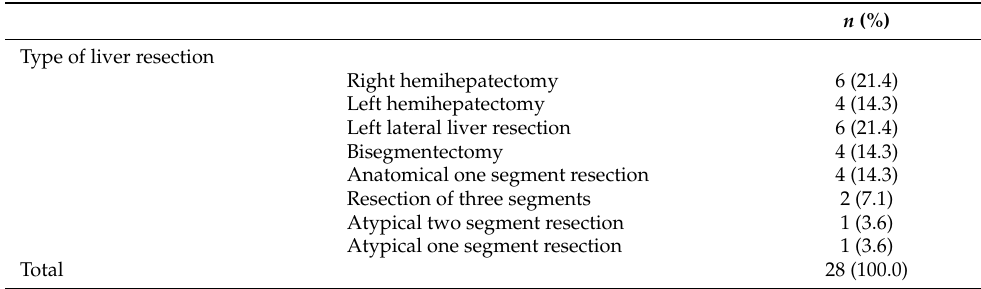
Table 2. Surgical procedures in patients who underwent major and minor robotic liver resection (RLR) using the three device (3D) technique for parenchyma dissection.